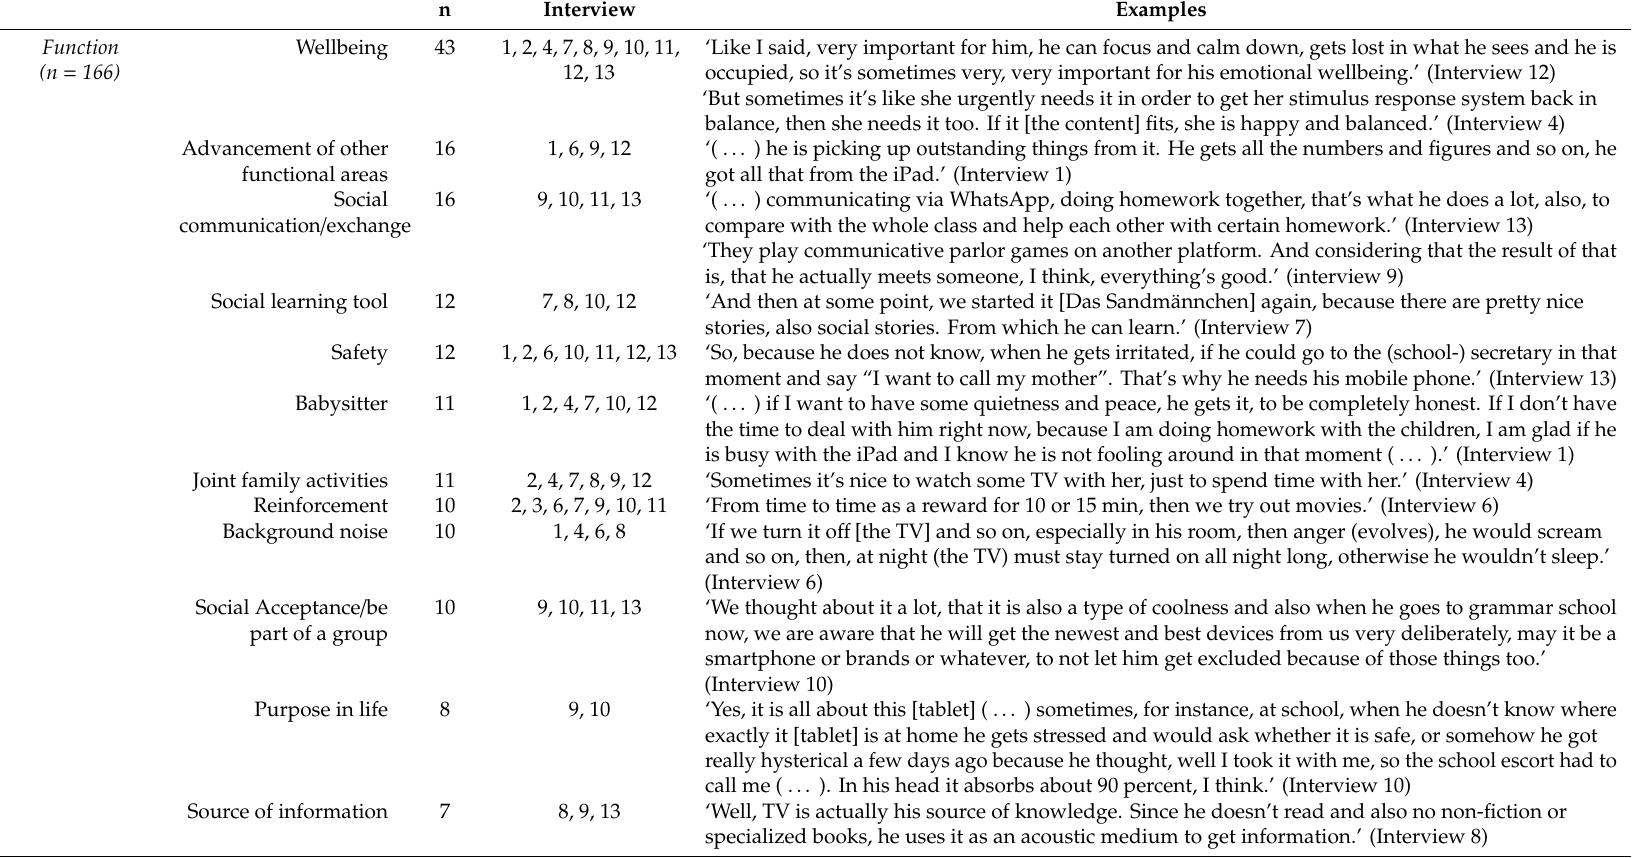
Table 3. Generated subcodes, their frequency of occurrence and some exemplary parental